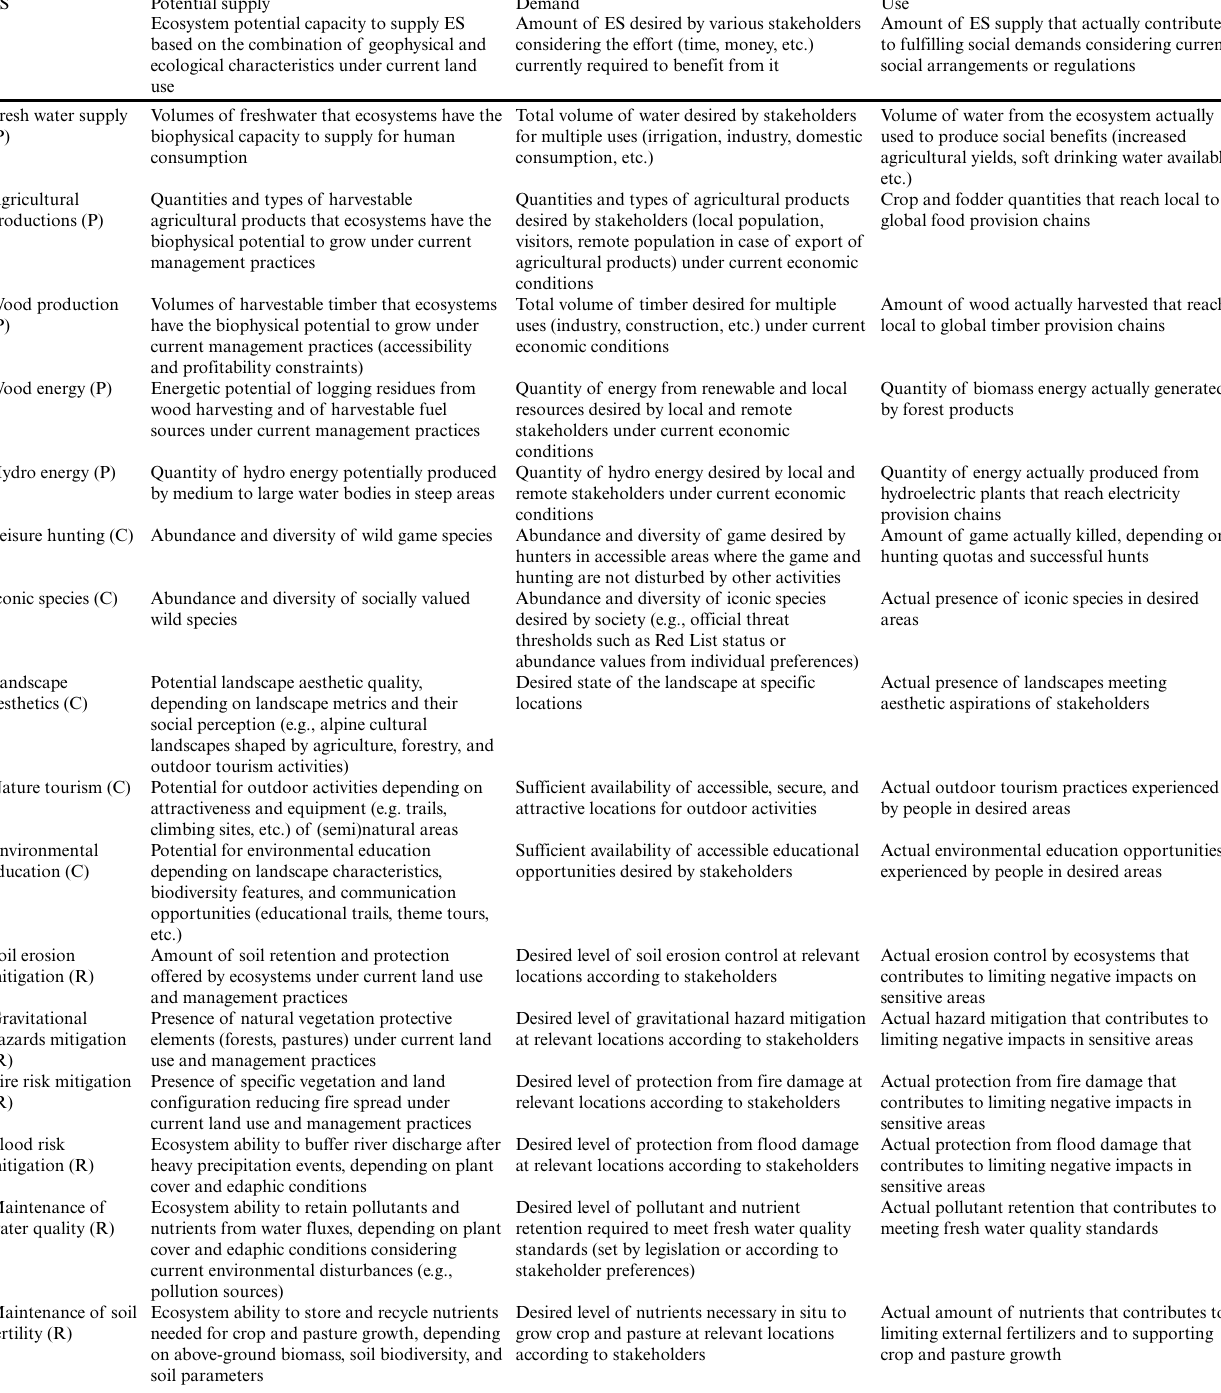
Table 1 . Ecosystem services (ES) discussed by stakeholders during the consultative process and specification of their three facets. Three ES categories are represented: provisioning ES (P), cultural ES (C), and regulating ES (R). Note: some ES might require other capital inputs in addition to natural capital to be used (Reyers et al. 2013, Fisher and Eastwood 2016, Palomo et al.